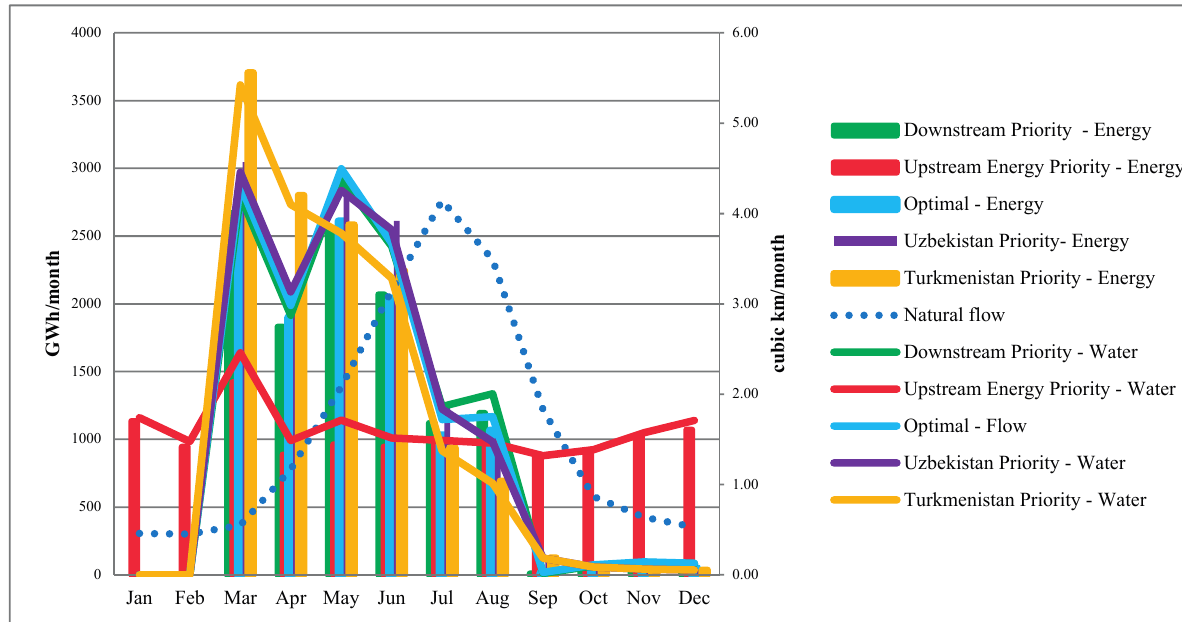
Figure 4. The model results showing monthly water discharge (on right y -axis) and corresponding energy production (on left y -axis) of the Rogun Hydropower Plant under five scenarios and the baseline (natural flow), averaged over 10 years. As can be seen, all five scenarios would significantly alter the natural flow, with “Upstream Energy Priority” leveling natural flow